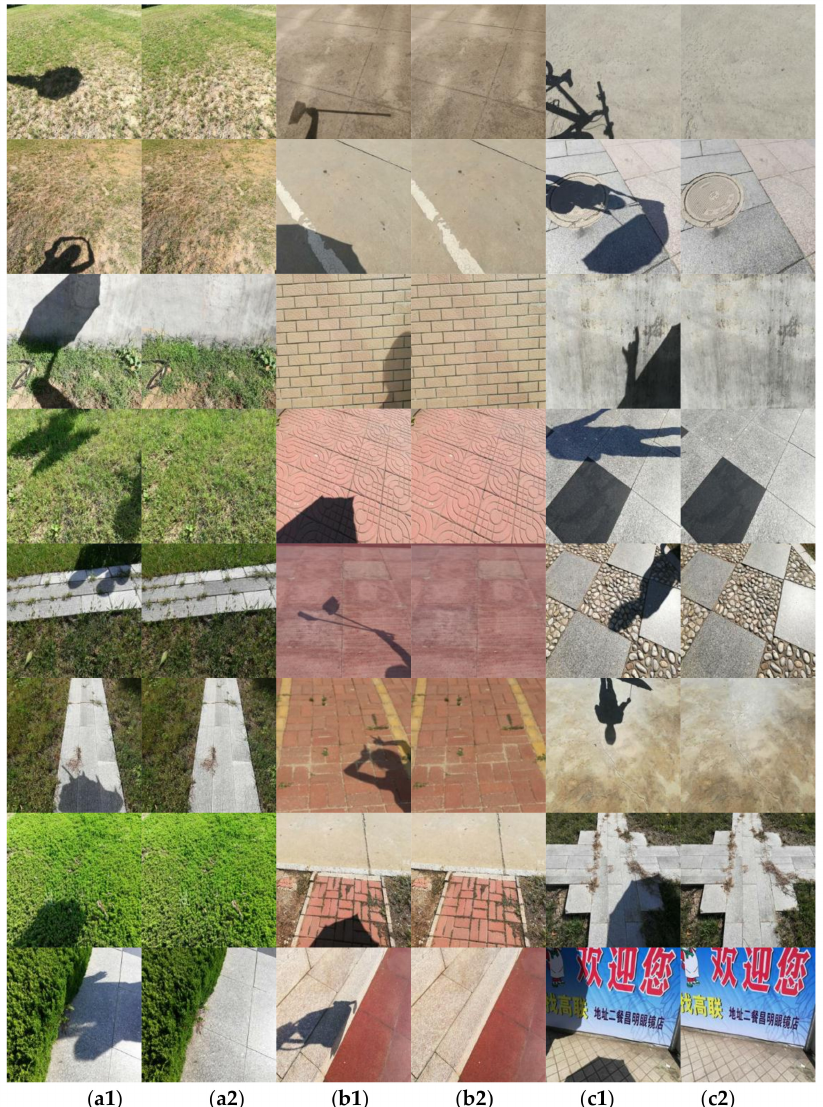
Figure 2. Illustration of several shadow and shadow-free image pairs in the RSDB database. The ( a1 , b1 , c1 ) columns show the shadow images (inputs) in different scenes. The ( a2 , b2 , c2 ) columns indicate true shadow-free images (targets) corresponding to the ( a1 , b1 , c1 )